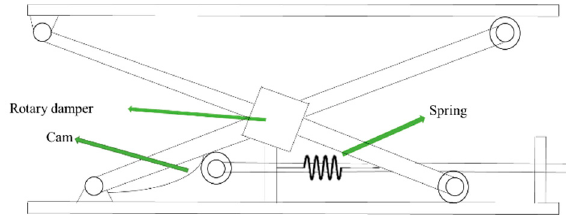
Figure 8. The structure of the seat suspension with rotary MR damper [80].